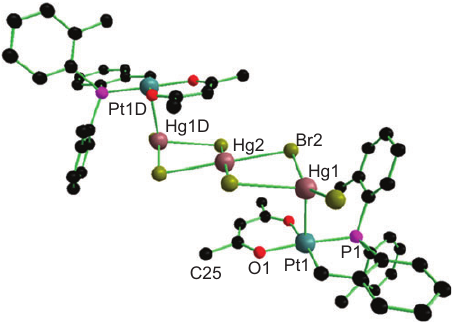
Figure 1 Molecular structure of [ { (PPh 2000). Phenyl groups are omitted for clarity.